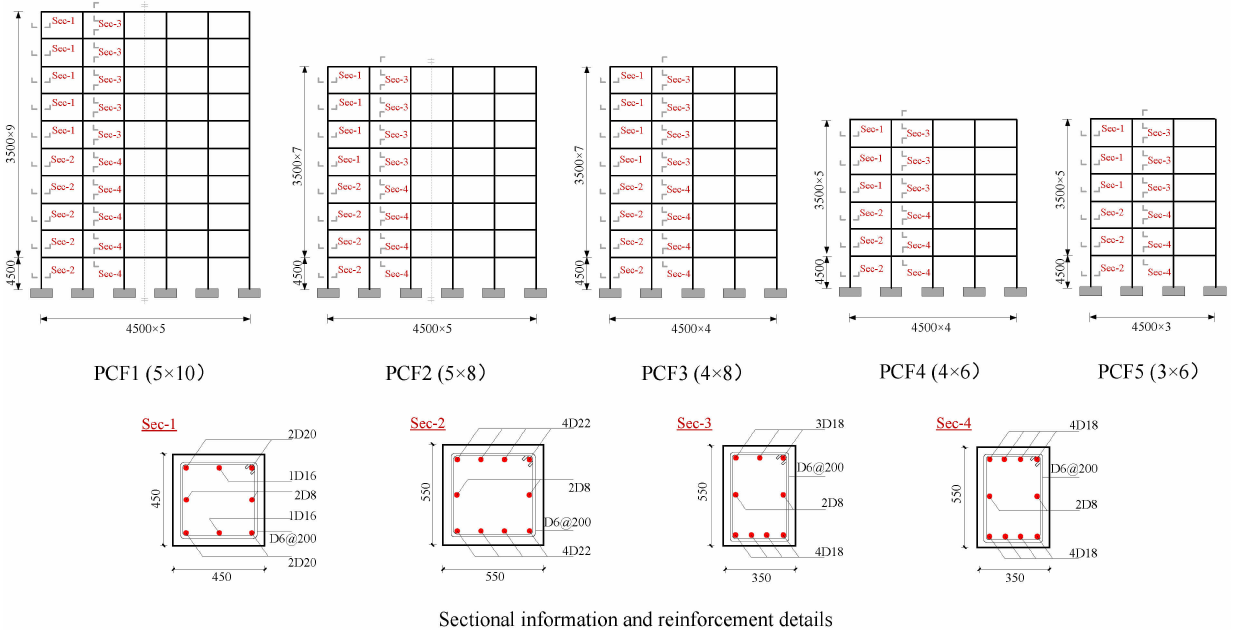
Figure 2. The dimensional details of the five PCFs in the application example.